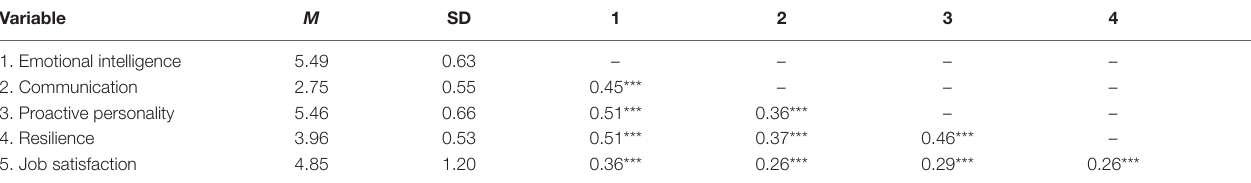
TABLE 1 | Means, standard deviations, and correlations for EI, communication competence, proactive personality, resilience and job satisfaction. Variable M SD